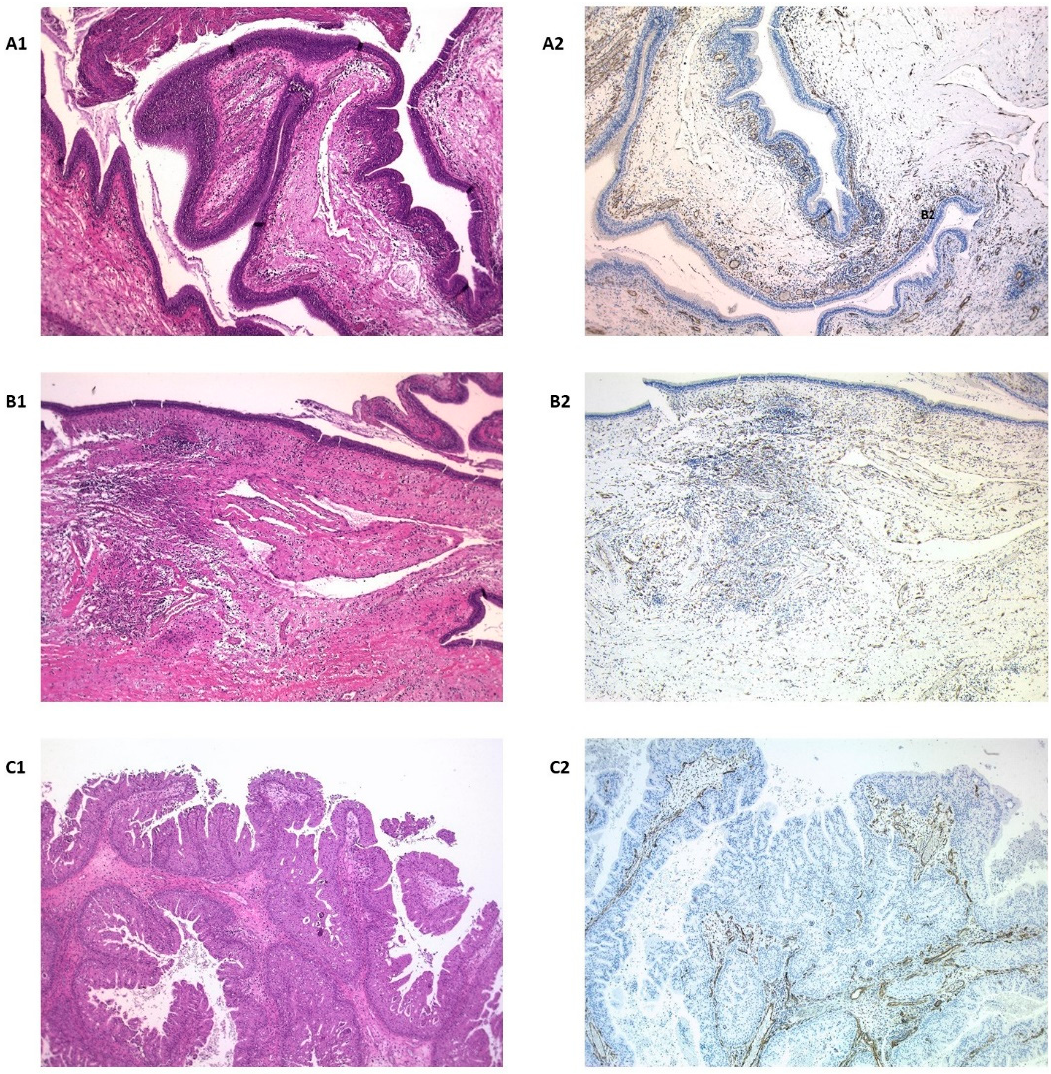
Figure 1. Normal nasosinus mucosa ( A1 ) showed nestin expression restricted to vessels and concentrated under the epithelium ( A2 ). Inflammatory polyps ( B1 ) showed the same staining pattern, consistent with its non-neoplastic nature ( B2 ). In inverted nasosinusal papillomas ( C1 ), the proliferative epithelium was always completely negative ( C2 ). The expression was categorized into grades, negative for 55 (62.5%) cases, grade 1 in 10 cases (11.4%), grade 2 in 12 cases (13.6%), and grade 3 in 11 cases (12.5%). There were no differences in terms of gender. Regarding origin, 84.6% nasosinus lesions were negative compared to those from the salivary gland and oral origin, which were positive (in different degrees) respectively, in 51.4% and 66.7% ( p = 0.001). Benign lesions were negative in 81.1% of the cases, against 49% of the malignant ones ( p < 0.001) (Figure 1(B1,C1)). In relation to the histological type, 100% of pleomorphic adenomas were positive for nestin with grade 3 intensity, 100% of polyps and inverted papillomas were negative ( p < 0.001) and the rest of the histological varieties were positive in a variable pattern (Figure